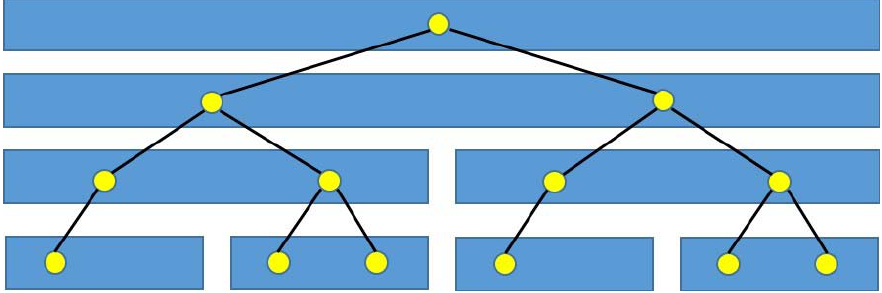
Figure 5. Subdivision of ESVO nodes on each level for storage on disk.